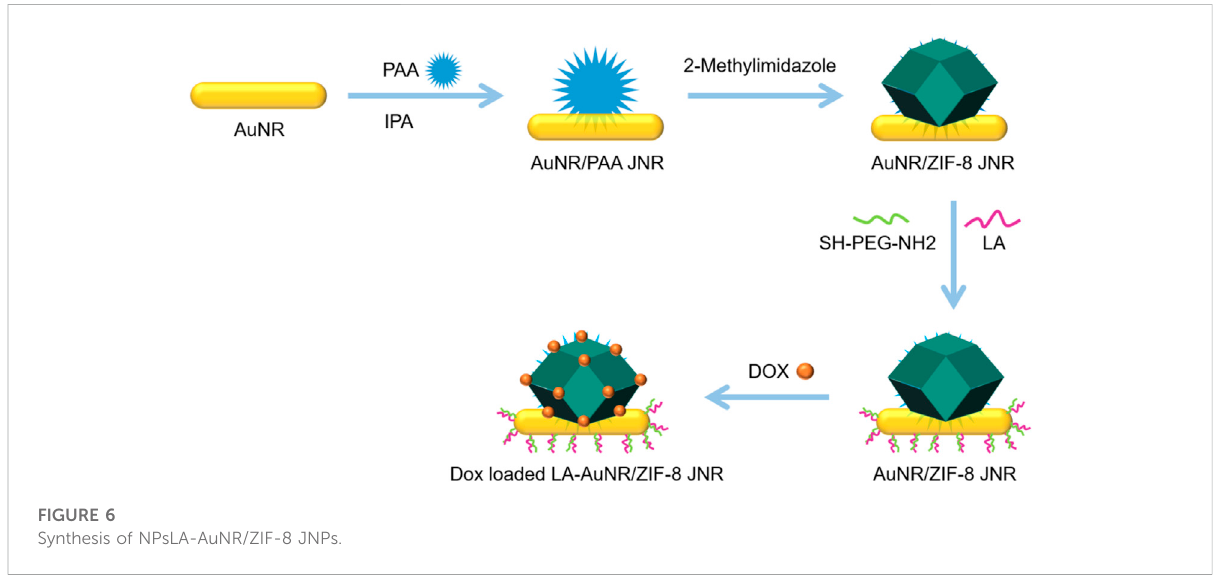
FIGURE 6 Synthesis of NPsLA-AuNR/ZIF-8 JNPs.